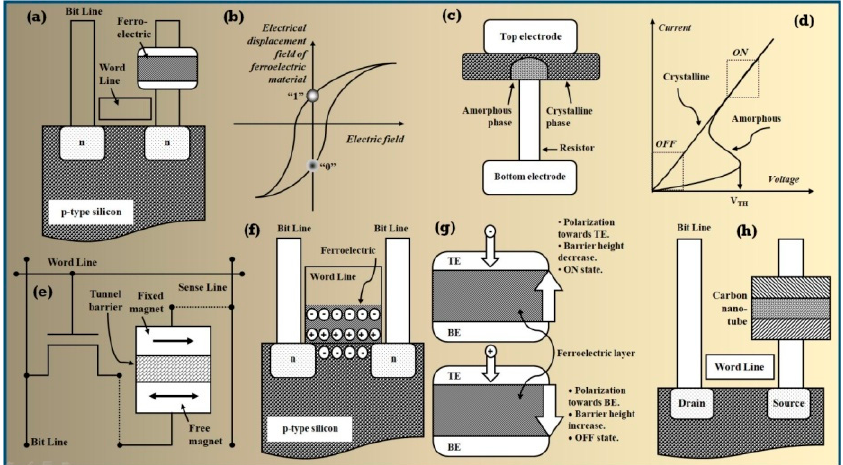
Figure 3. Schematic illustration of the ( a ) ferroelectric random-access memory (FeRAM) device structure and ( b ) the hysteresis behavior; ( c ) the structure of phase change memory (PCM) and ( d ) the I–V switching, ( e ) spin-transfer-torque RAM (STTRAM) structure, ( f ) ferroelectric field effect transistor (FeFET) design, ( g ) ferroelectric tunnel junction (FTJ) structure, and ( h ) carbon nanotube (CNT)-based carbon memory device structure.